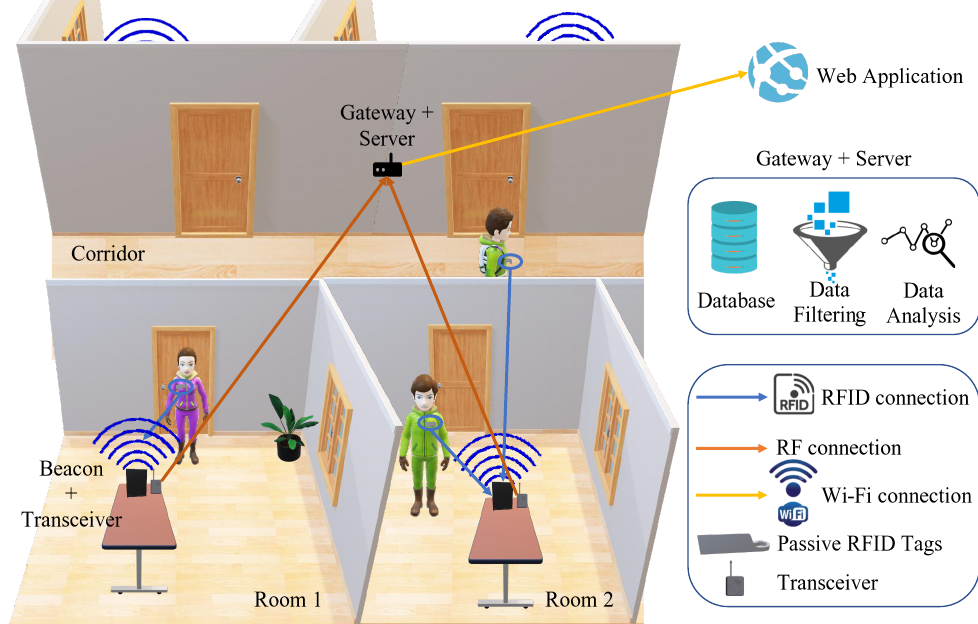
Figure 9. RFID based contact tracing system architecture